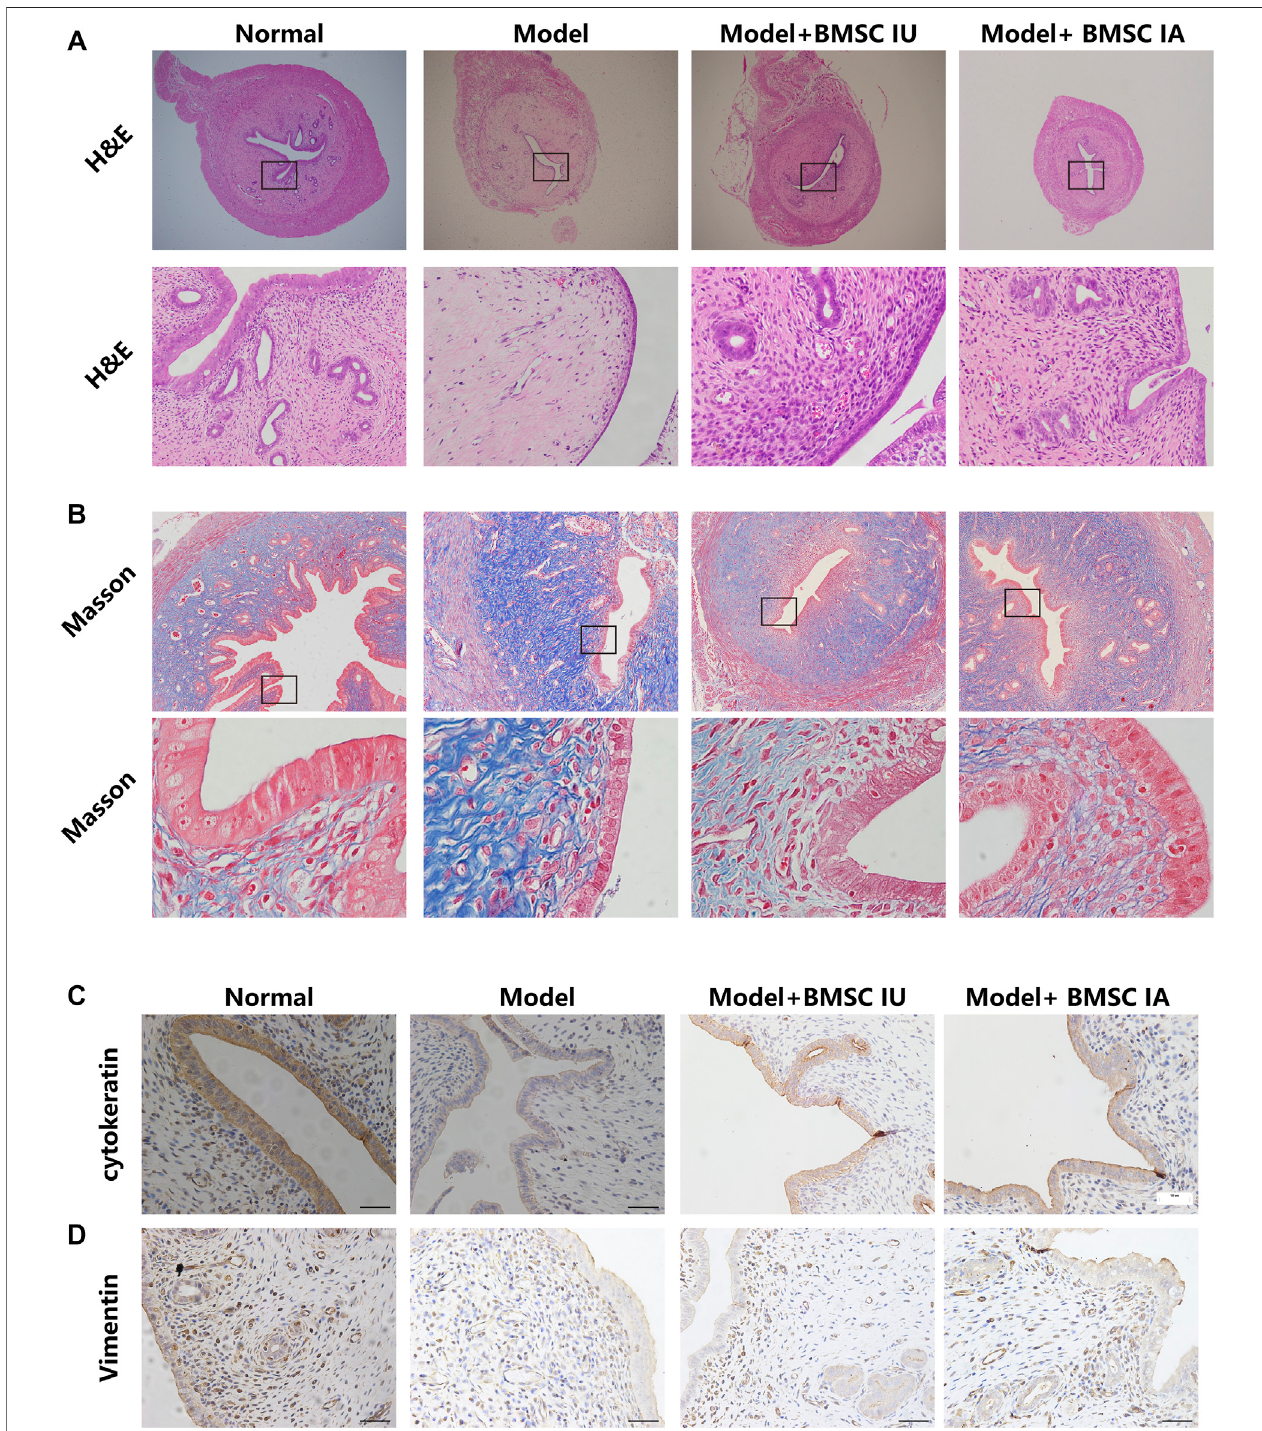
FIGURE5| Morphological evaluation oftheregenerative effect ofBMSCsadministered differentlyon the thinendometrium. The endometriummorphologies in the four groups (normal, model, BMSC IU-injection, and BMSC IA-injection) were examined by H&E staining (A) and Masson ’ s trichrome staining (B) . H&E indicates hematoxylin and eosin. Immunohistochemical analysis of the cytokeratin (C) and vimentin (D) expression in the four groups.